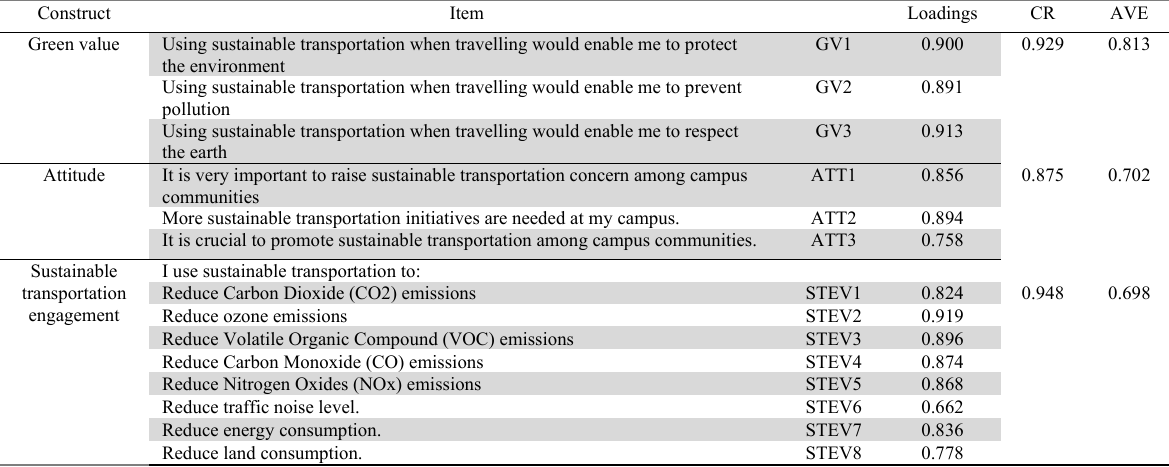
Heterotrait-Monotrait (HTMT)